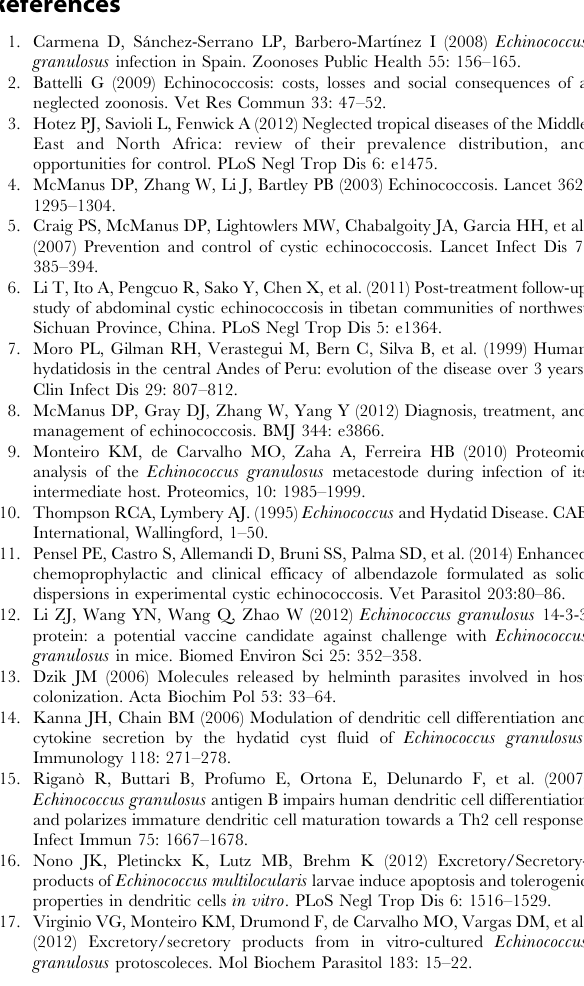
S5 Figure Gene ontology (GO) analysis of the identified ESPs from the Eg PSCs transcriptome. The figure shows the number of mapped proteins identified in this study as a function of all the available GO terms of level 2 for (A) biological process, (B) cellular component, and (C) molecular function. (TIF) S1 Table KEGG pathway analysis of the Eg PSCs transcriptome sequences. (XLSX) S2 Table Validation evaluation of the predicted ESPs from the Eg PSCs transcriptome. (XLS) S3 Table Overview of the predicted ESPs from the Eg PSCs transcriptome. ESPs were conceptually translated and inferred from the coding domains of transcriptomic sequences. Domain analysis of ESPs was then carried out using InterProScan. (XLS) S4 Table Domains associated with carbohydrate me- tabolism in the ESP. (XLSX) S5 Table Domains related to post-translational modifi- cation, protein turnover, and chaperones in the ESPs. (XLSX)